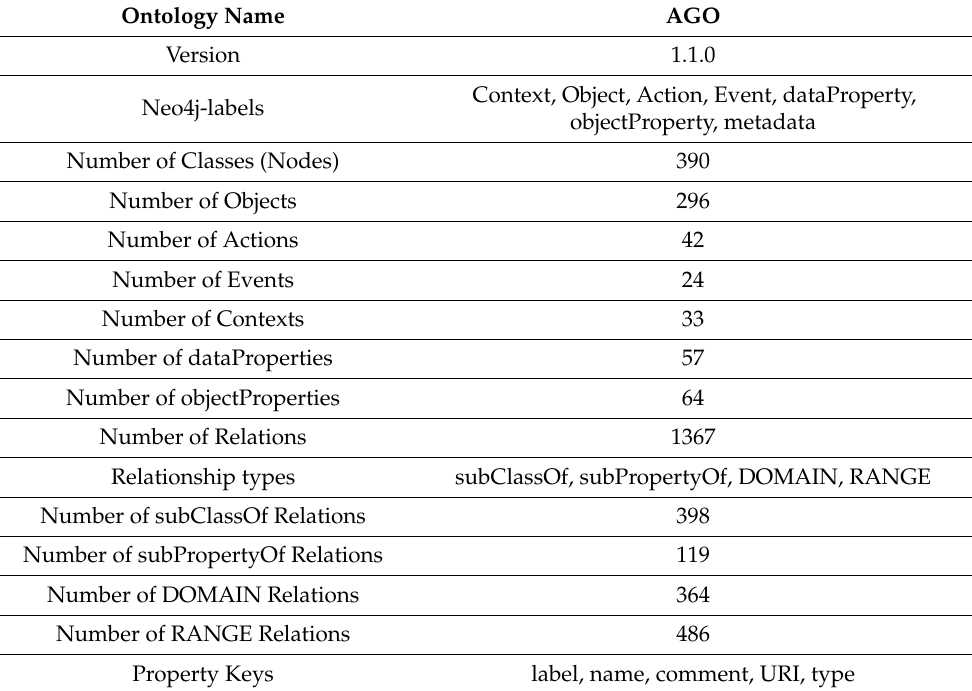
Table 2. Main characteristics of the ontology.